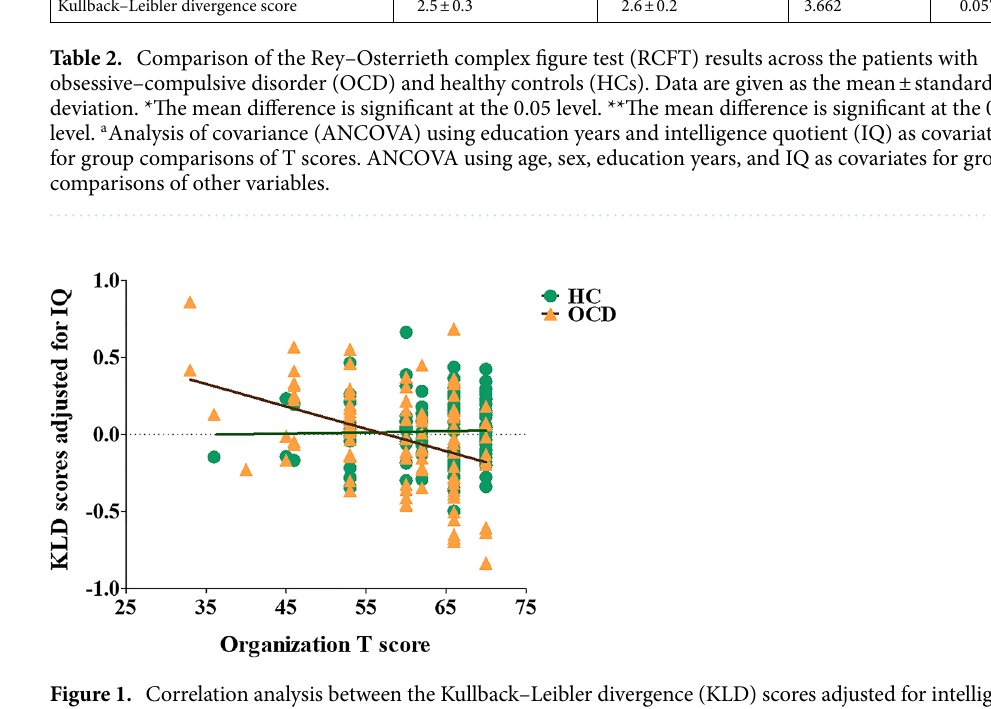
Figure 1. Correlation analysis between the Kullback–Leibler divergence (KLD) scores adjusted for intelligence quotient (IQ) and the organization T scores in obsessive–compulsive disorder (OCD) patients (r = − 0.405, p < 0.001) and healthy control (HC) subjects (r = 0.032, p =